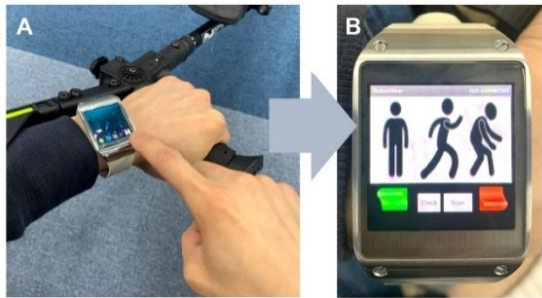
Figure 6. The wearable smartwatch for exoskeleton manual controller ( A ) and the application which was replaced by the BCI controller in this study ( B ).